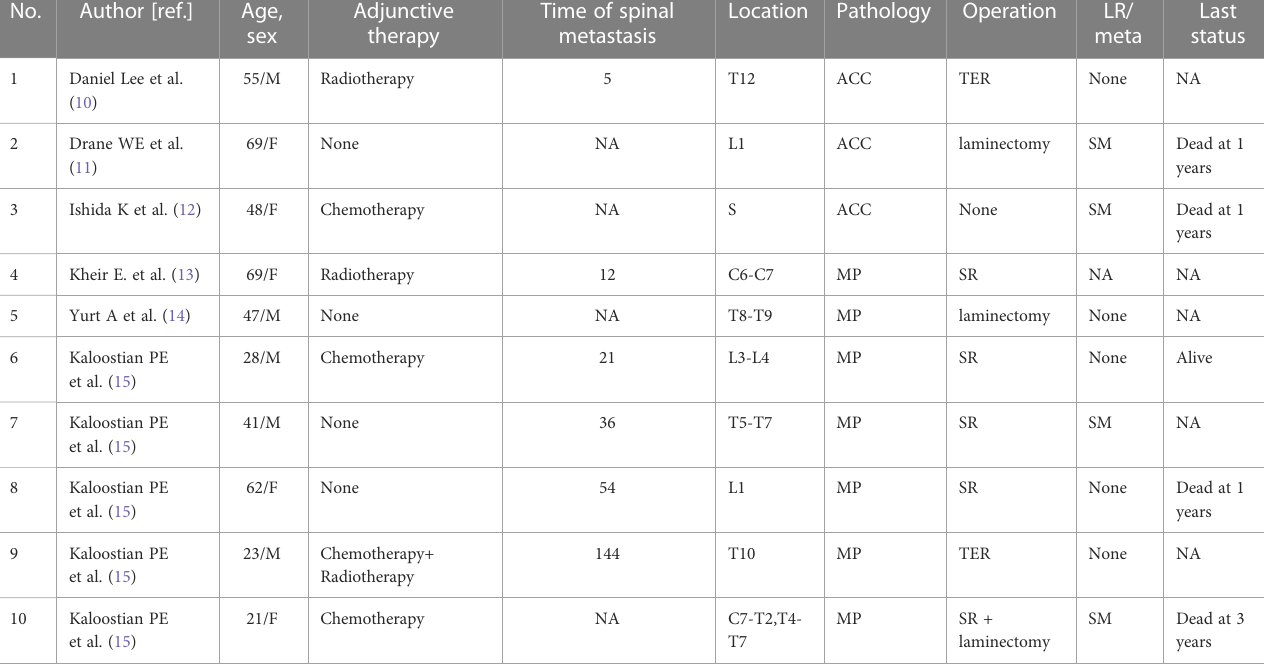
TABLE 2 Literature review for